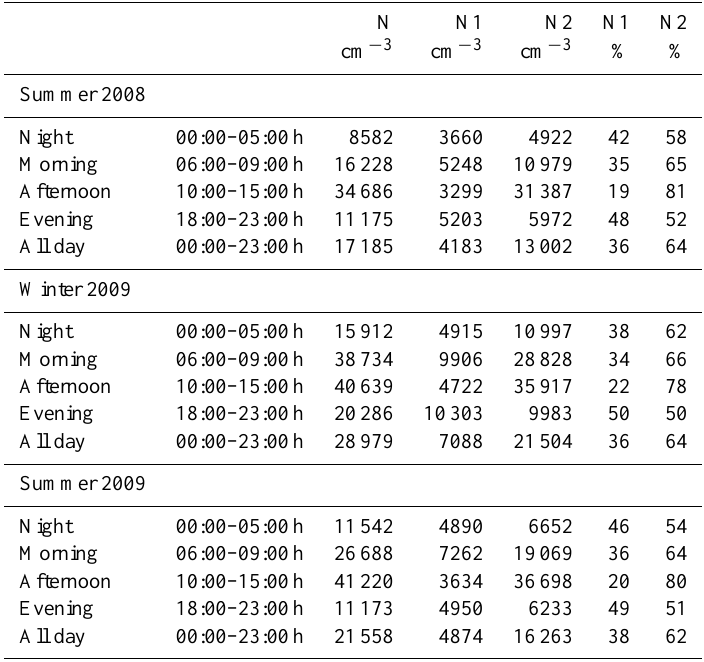
Table 3. Mean number concentrations and contributions of N1 and N2 in different periods during the whole study period, in winter and in summer.